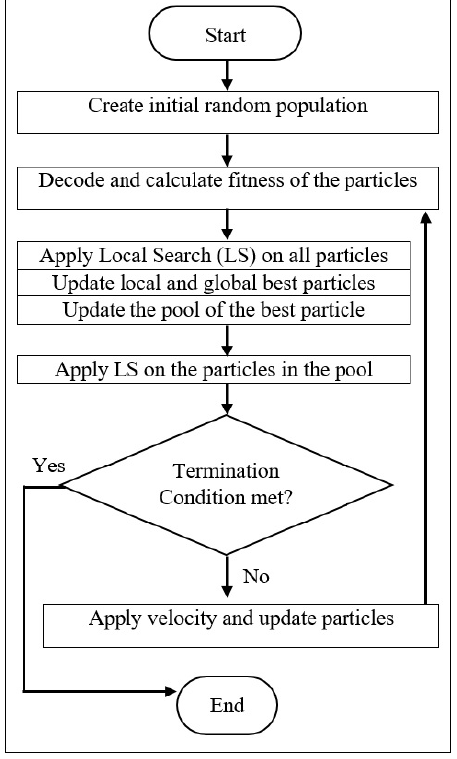
Figure 2. Flowchart diagram of the proposed BLS-PSO.